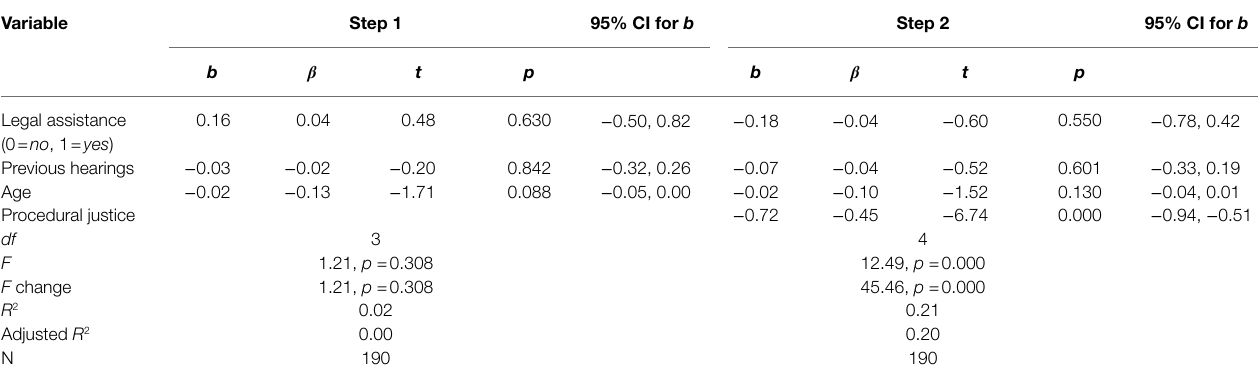
TABLE 5 | Protest intentions regressed on procedural justice and relevant background